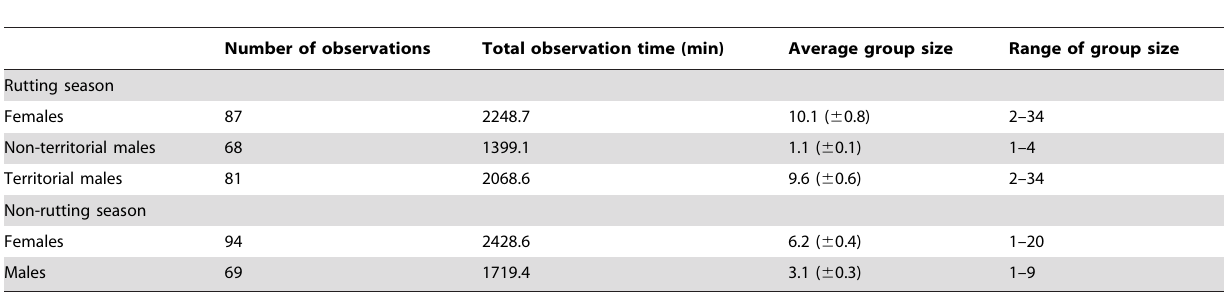
Table 1. Summary of focal observation samples as a function of individual status in Przewalski’s gazelle.